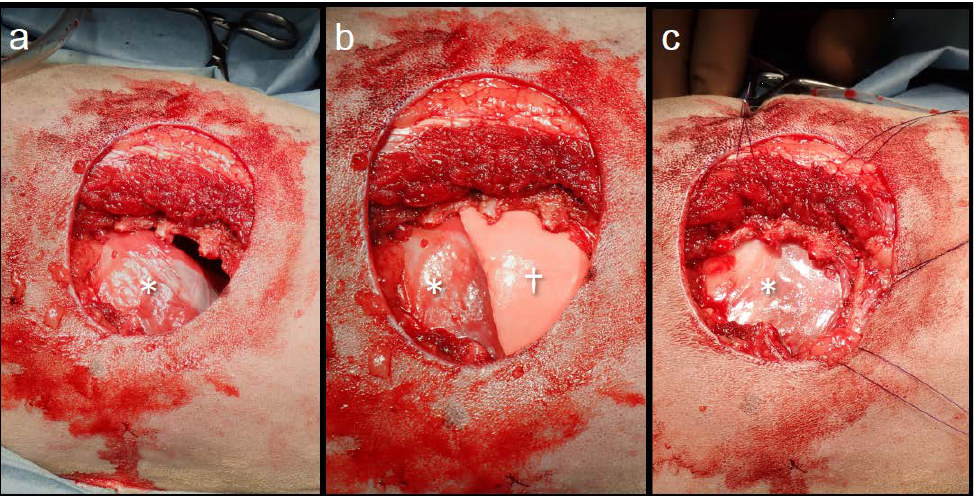
Figure 2. Images of the thoracic wall defect. ( a ) Full thickness of the thoracic wall resection, including the 11–13th ribs; ( b ) The lungs were inflated at 15 mm Hg on the pressure gauge of the anesthesia machine. The caudal border of the right caudal lung lobe advanced to approximately half of the defect site; ( c ) The diaphragm was pulled and sutured to the thoracic wall. The dog was positioned ventrally, with the cranial side on the right side of the images. *: diaphragm; †: right caudal lung lobe.